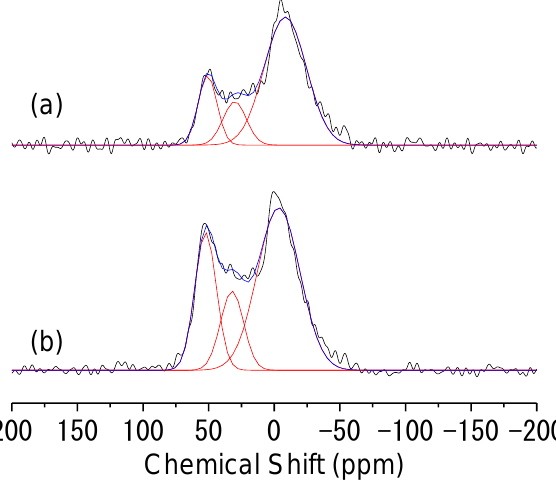
Figure 1. 27 Al MAS NMR spectra of 1Al_SBA-15 ( a ) and 5Al_SBA-15 ( b ).